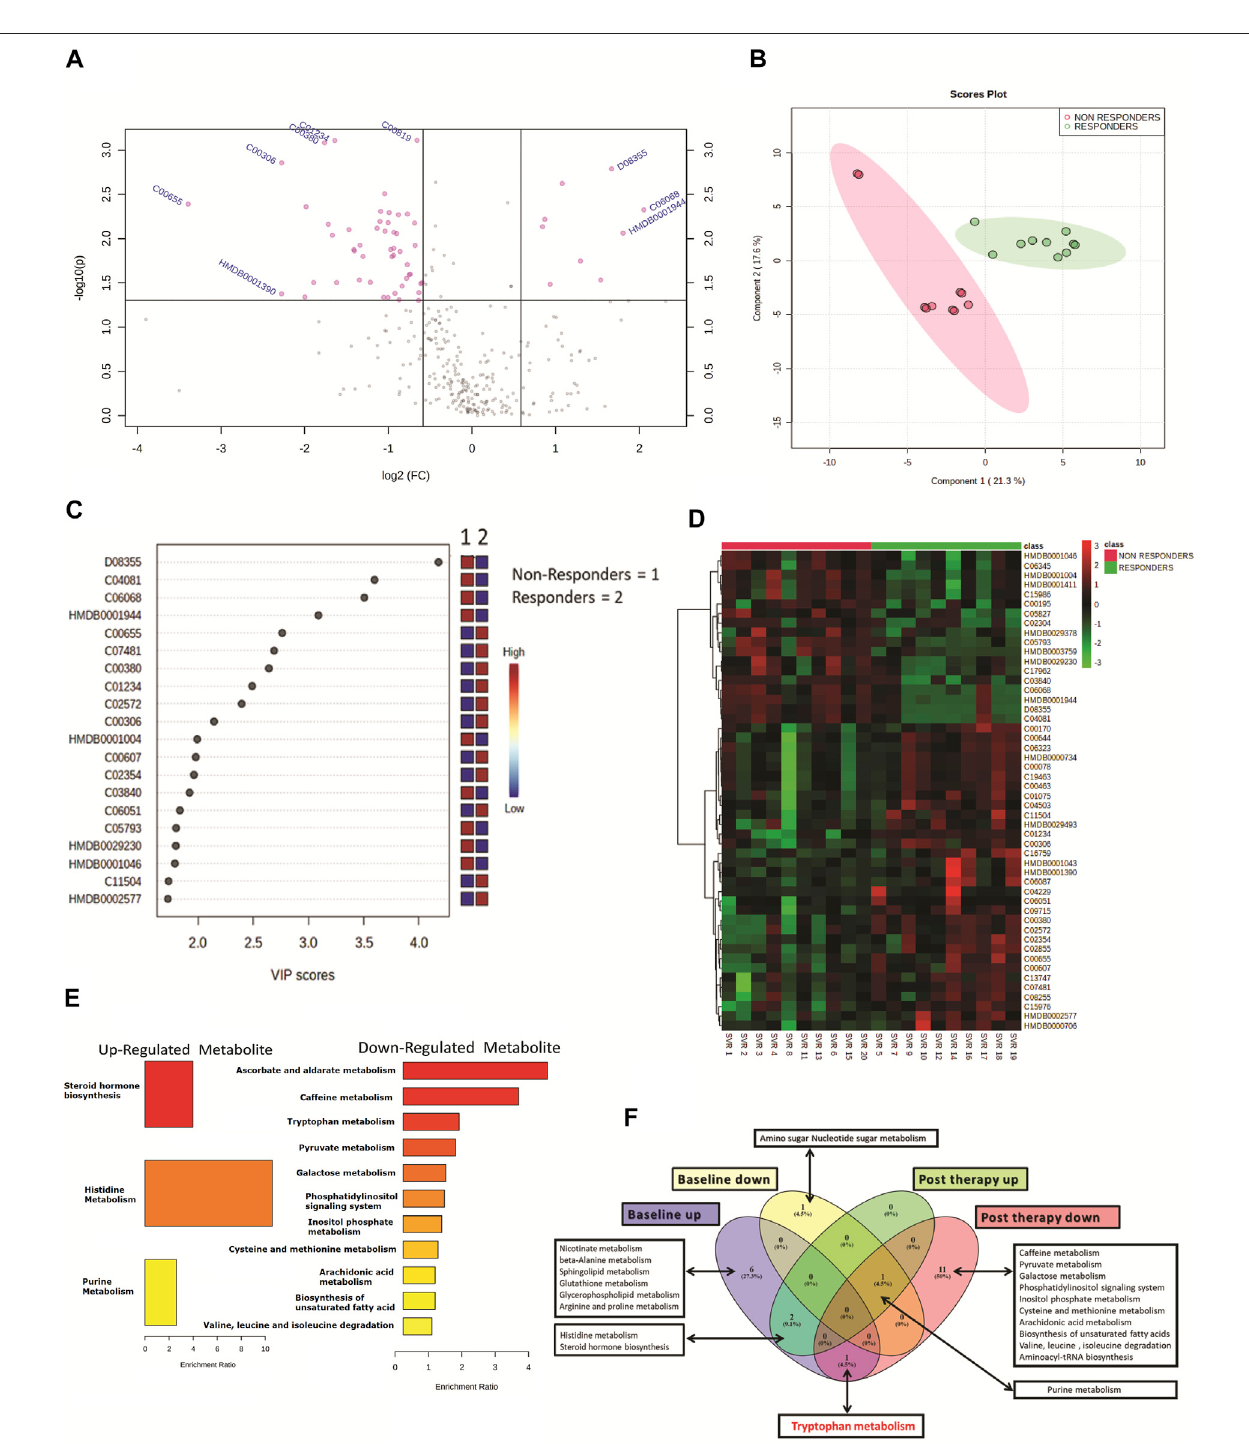
FIGURE2|(A) VolcanoplotshowingdifferentiallyexpressedmetabolitesinDAAnonrespondersvs.DAAresponderspostDAAtherapy.Pinkdotsaresigni fi cantat p < 0.05. (B) Partial least square discriminant analysis (PLSDA) showing clear segregation of DAA nonresponders and DAA responders post therapy based on the metabolome pro fi le of patients. Pink dots correspond to nonresponders, and green dots correspond to responders. (C) Variable importance in projection (VIP) plot displaying the top 20 most important metabolite features identi fi ed by PLSDA post therapy. Colored boxes on the right indicate relative concentration of the corresponding metabolite between DAA nonresponders vs. DAA responders post therapy. (D) Heat map and hierarchical clustering analysis of top 50 metabolites are capable to segregate DAA nonresponders (red bar) from DAA responders (green bar) post therapy. The expression is given as red (cid:1) upregulated, green (cid:1) downregulated, and black (cid:1) unregulated. (E) KEGG pathway analysis of upregulated and downregulated metabolites in DAA nonresponders as compared to those in DAA responders post therapy. (F) Venn diagram showing unique and common pathways in nonresponders vs. responders at baseline as well as post therapy.